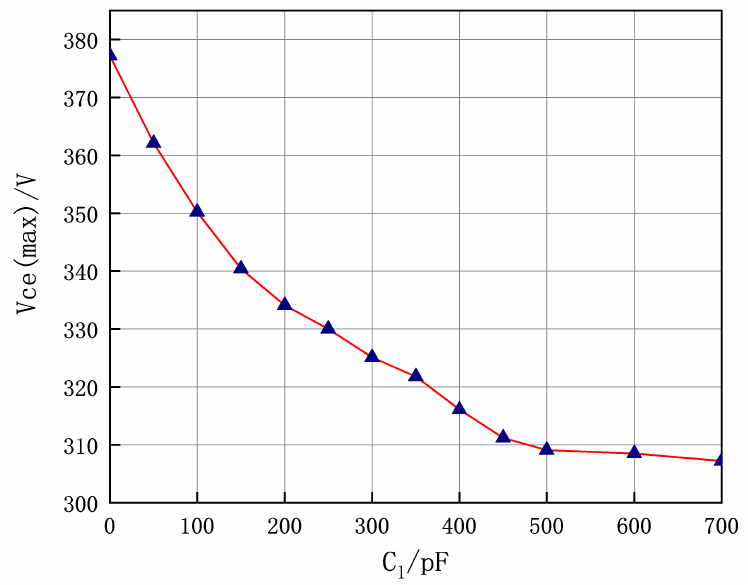
Figure 6. Curve of V ce ( max ) changing with C 1 .